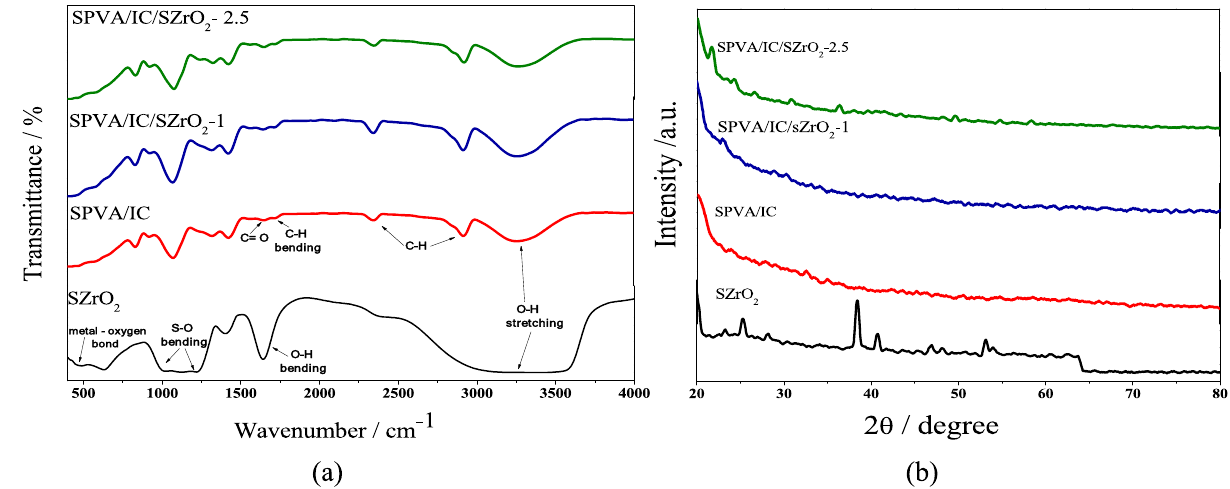
Figure 1. ( a ) FTIR spectra of SZrO 2 and SPVA/IC/SO 4 ZrO 2 composite beads, ( b ) XRD patterns of SZrO 2 and SPVA/IC/ SZrO 2 composite